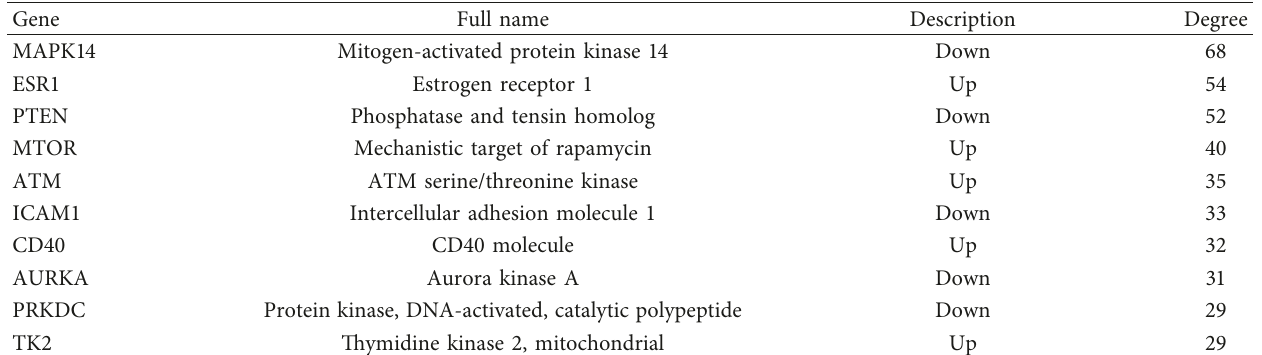
Table 1: List of top 10 differentially expressed genes with higher degrees in protein-protein interaction